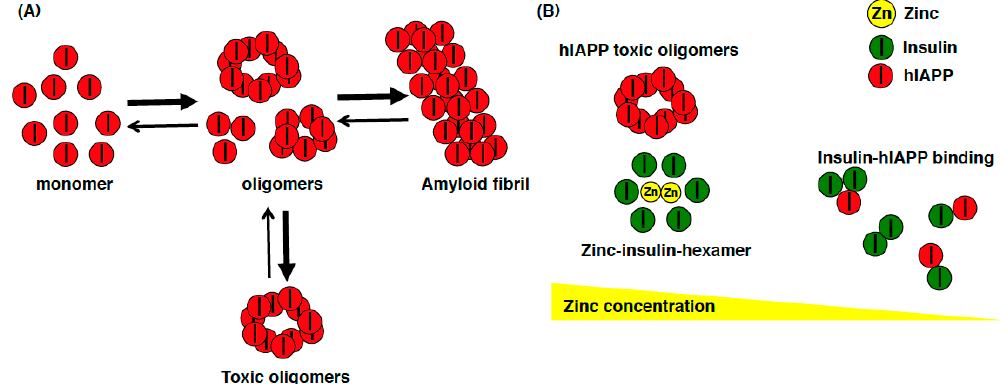
Figure 2. Schematic model of the relationship among hIAPP , insulin, and zinc. ( A ) hIAPP can easily form toxic oligomers that induce apoptosis and amyloidogenesis in β cells in T2DM patients; ( B ) When the zinc concentration in insulin secretory granules is high, zinc is used to form zinc-insulin- hexamer, and hIAPP can easily form toxic oligomers. On the other hand, when the zinc concentration is low in insulin secretory granules (such as insulin secretory granule in ZnT8-KO mice), insulin exists as monomer or dimer, which preferentially binds to hIAPP monomer and prevents hIAPP from self- associating and